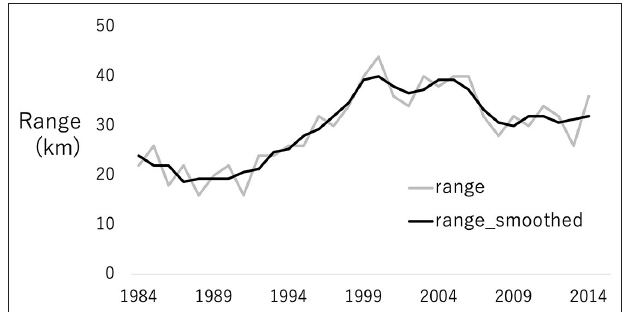
FIGURE 5 | Estimated range of the spatial spill-over from the Tokyo station. The gray line represents the raw estimates, and the black line represents the smoothed estimates, which are used in the subsequent